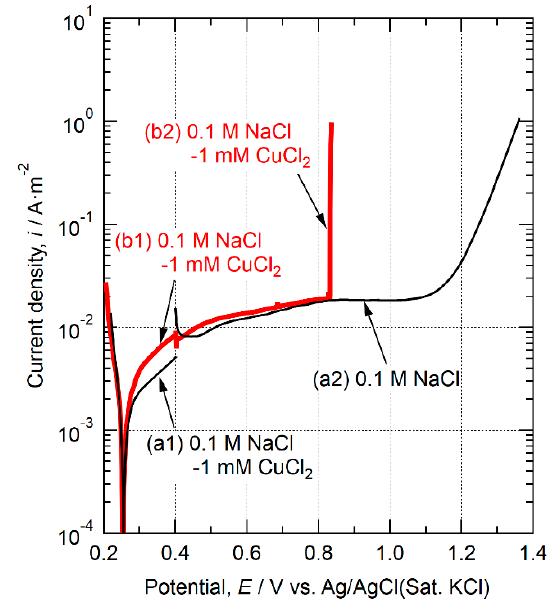
Figure 8. Anodic polarization curves polarized to 0.4 V in (a1, b1) 0.1 M NaCl, and polarized from 0.4 V in (a2) 0.1 M NaCl and (b2) 0.1 M NaCl-1 mM CuCl 2 .